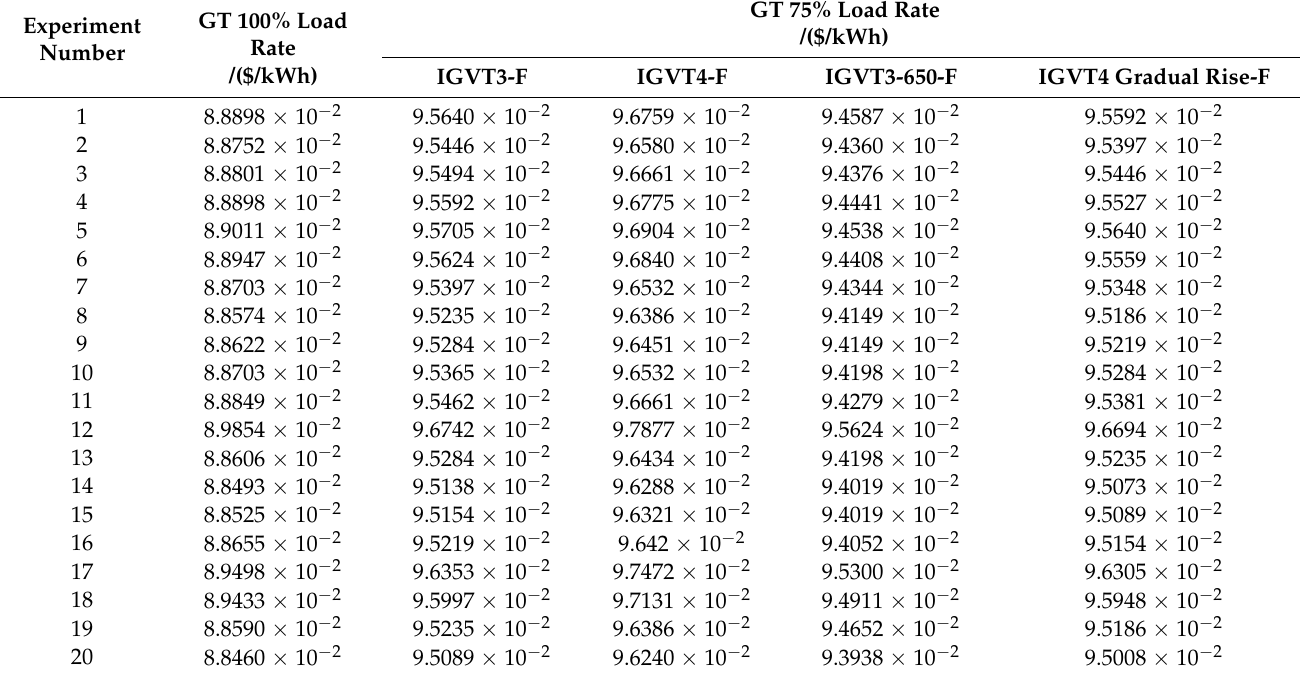
Table 6. Orthogonal test results (GT 100% and 75% load